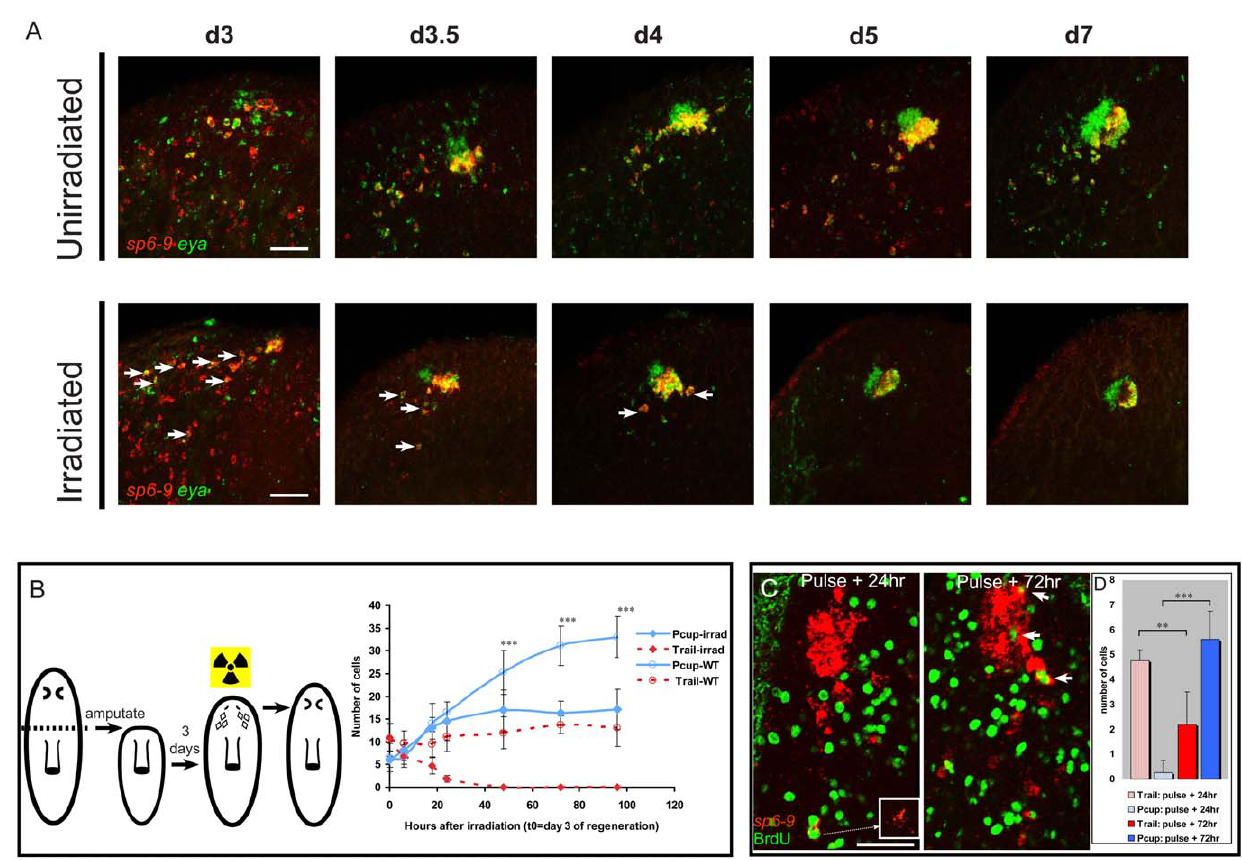
Figure 5. Optic cup trail cells are a source of new optic cup tissue. All fluorescent images are FISH, except for fluorescent detection of BrdU by antibody. (A) Time course of eye regeneration in unirradiated animals and animals irradiated at day 3 of regeneration following decapitation. In irradiated panels arrows indicate double positive cells. (B) Experimental design diagram and quantification of cell numbers in pigment cups (Pcups) and trails of irradiated and unirradiated animals over time (mean 6 s.d; n $ 9 eyes/trails; significance by two-tailed t-test is shown for the Pcup cell numbers in irradiated vs. un-irradiated *** P , .05). (C) BrdU injection at day three of regeneration after decapitation only labels trail cells after one day, but labels Pcup cells after a longer time delay. Inset: magnification of sp6-9 signal in BrdU/ sp6-9 -positive cell. Arrowheads indicate sp6-9 + / eya + /BrdU + Pcup cells. (D) Quantification of BrdU + / sp6-9 + / eya + cell numbers in the trail and Pcup 24 h and 72 h after BrdU injection (mean 6 s.d; n=5 eyes; significance by two-tailed t-test *** P , .001, ** P , .005). Scale bars, 50 m